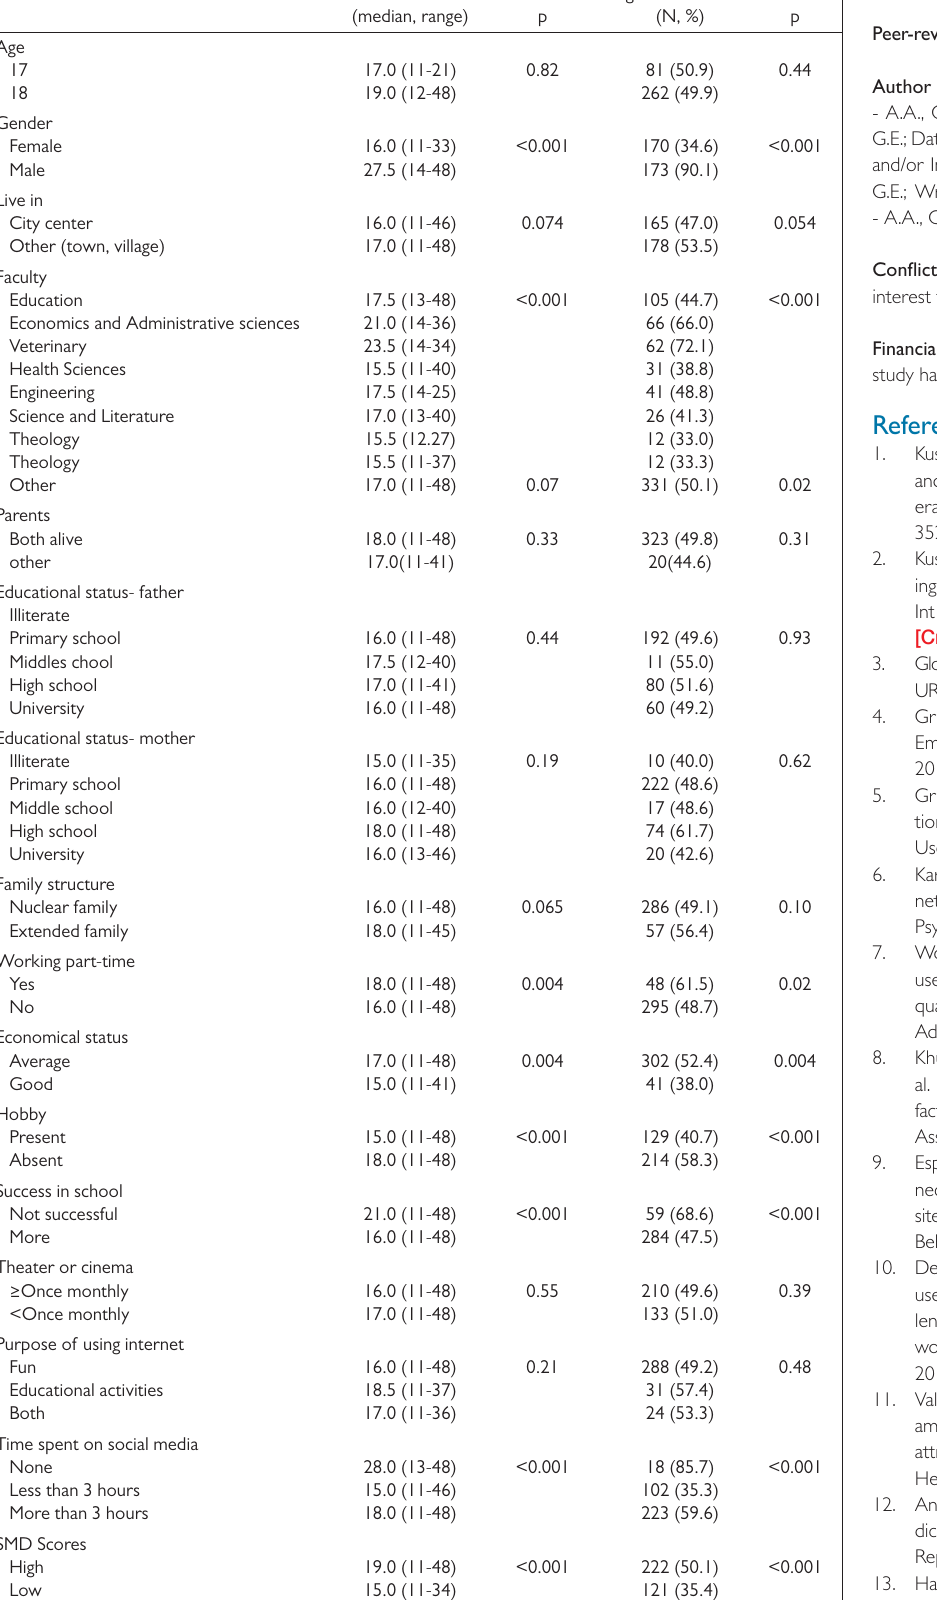
Table 4. Factors associated with OES-A scores